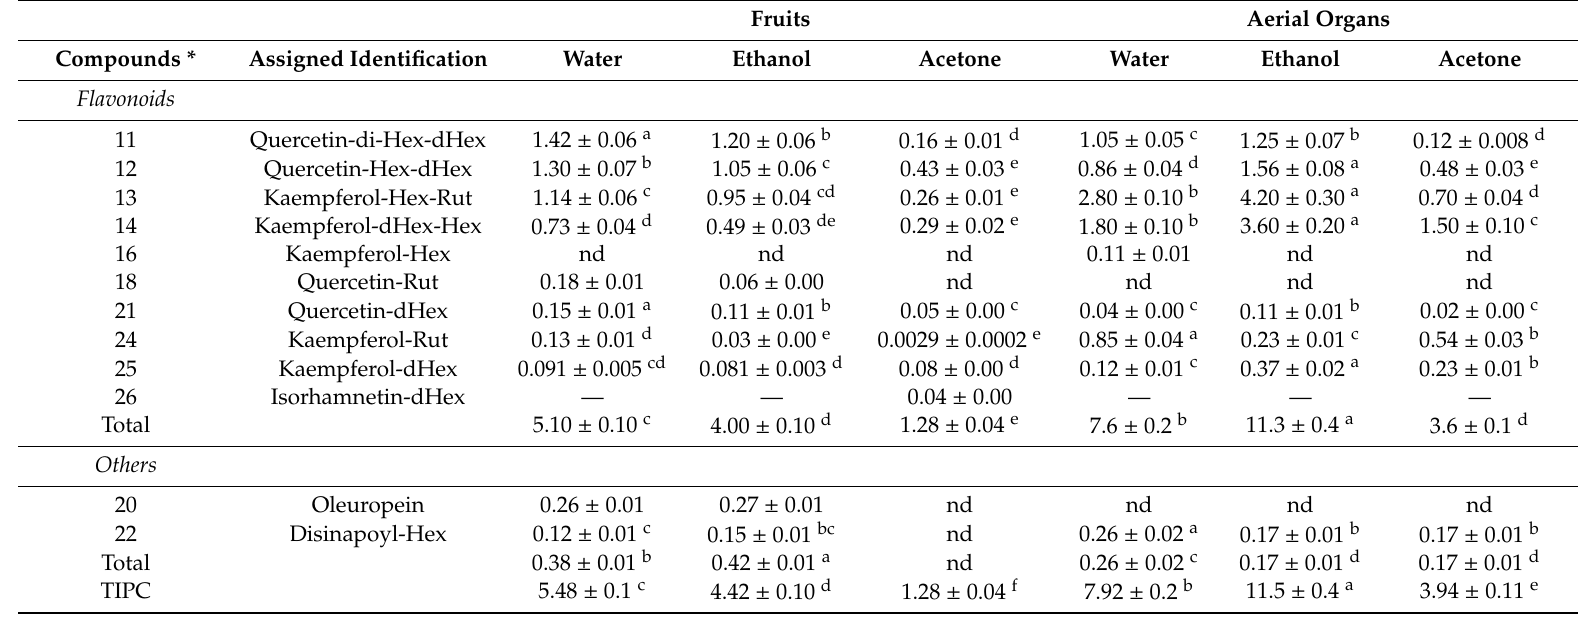
* Compounds refer to those presented in Table 1 and Figure 1. TIPC: Total individual phenolic content (the sum of all phenolics individually quantified). For the same row, di ff erent letters are significantly di ff erent (Multiple Comparisons of Means: Tukey Contrast, 95% family-wise confidence